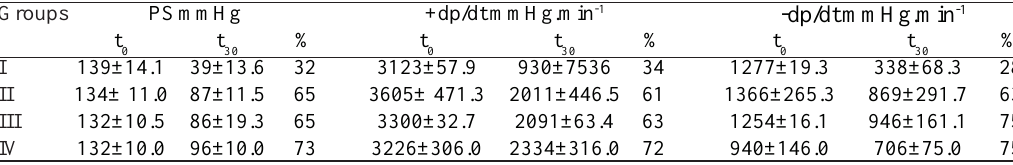
Table 2. Systolic pressure, +dp/dt and -dp/dt average results